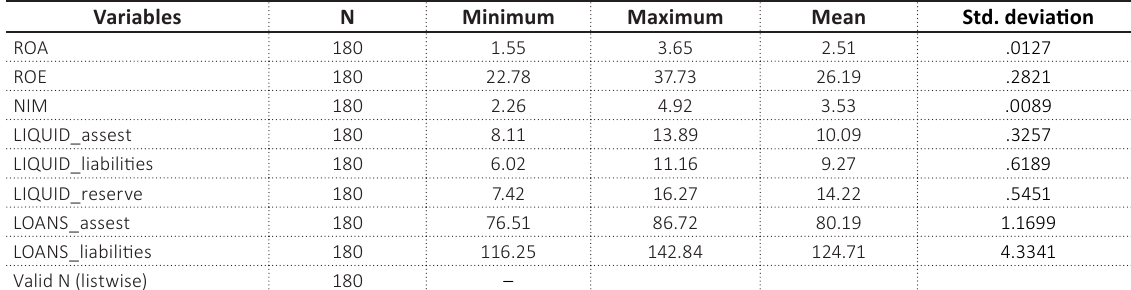
Table 3. Model summary